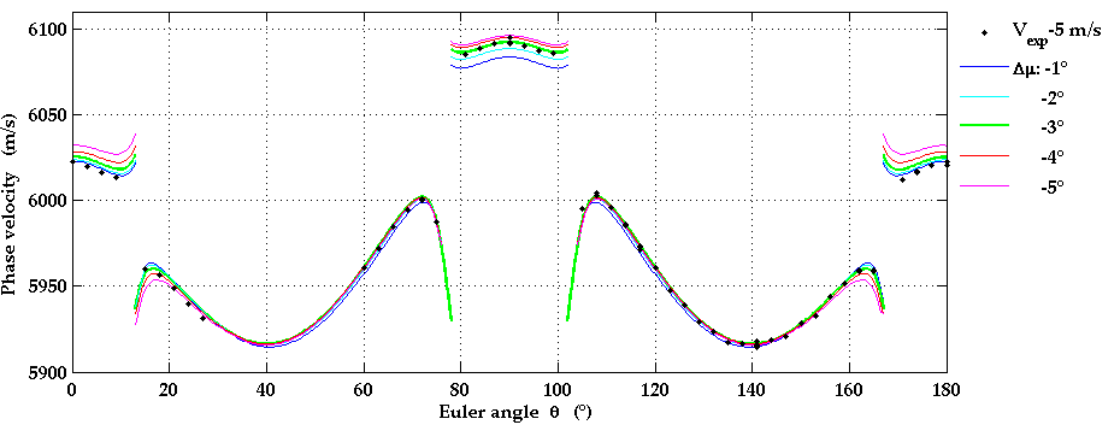
Figure 8. Influence of the off-cut angle χ on the angular dependence of the SAW phase velocity on Al 2 O 3 (1-102). Here, the experimental results are downshifted by 3 m/s.